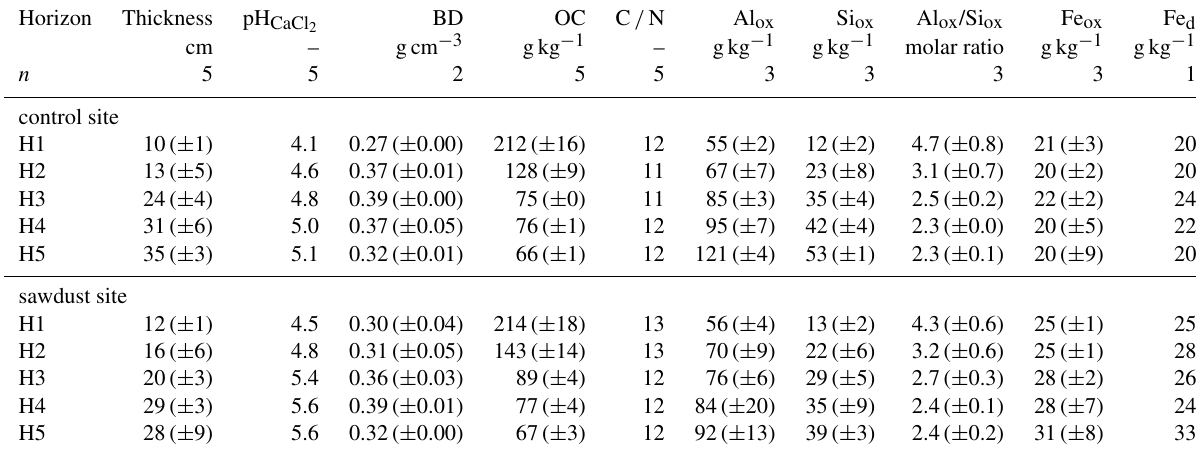
Table 1. Selected bulk properties of the studied Andosol. Soil horizon thicknesses, pH values, bulk densities (BD), bulk organic carbon (OC) concentrations and carbon nitrogen ratios (C / N) are given as means with the standard error where appropriate. The Al ox , Si ox , and Fe ox represent ammonium-oxalate–oxalic-acid-extractable aluminium, silicon, and iron and are given as the mean concentrations and standard error. Fe d is dithionite-extractable iron analysed with samples from only one profile per site. The concentrations of Al, Si, and Fe are normalized to the mineral part (or inorganic part) of the dry soil assuming that the mass of OM is 2 times the mass of OC (Sollins et al., 2006). The row marked with n represents the number of profiles analysed per site.